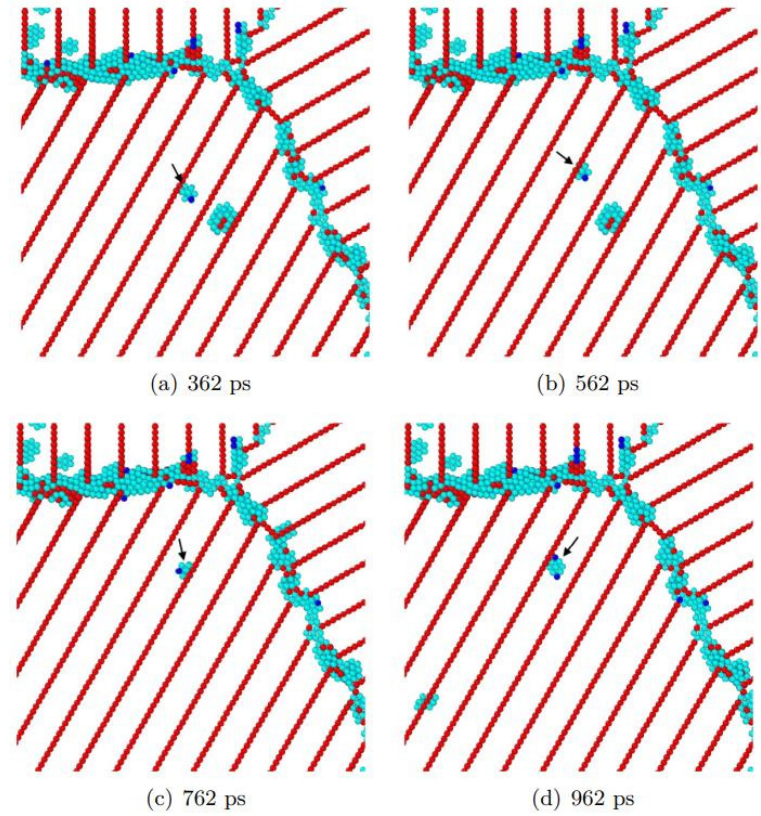
Figure 7. ( a )–( d ) Atomistic images showing the point defect cluster crossing a CTB at different simulation time during equilibration after radiation cascade. Atoms are color coded according to their structures (blue—BCC; red—HCP; cyan—other structure; FCC atoms not shown). Reproduced with permission from Ref. [82]. Copyright 2021 Clearance